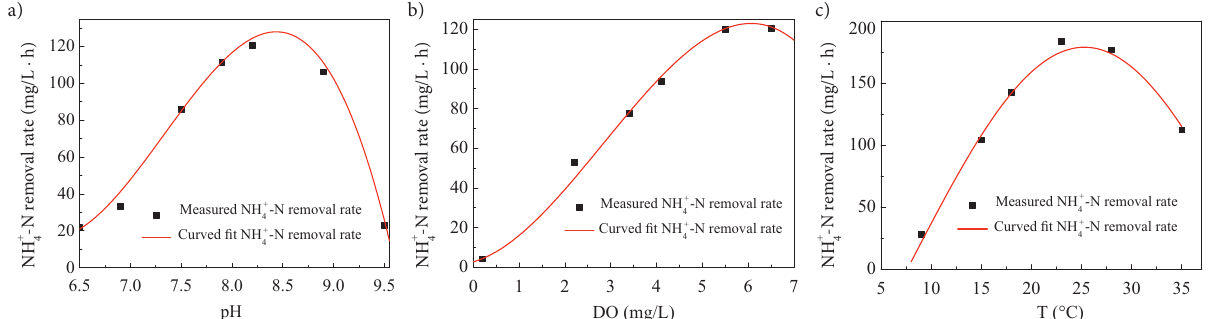
Figure 2. NH 4+ -N removal rate under different pH (a), DO (b) and T (c)